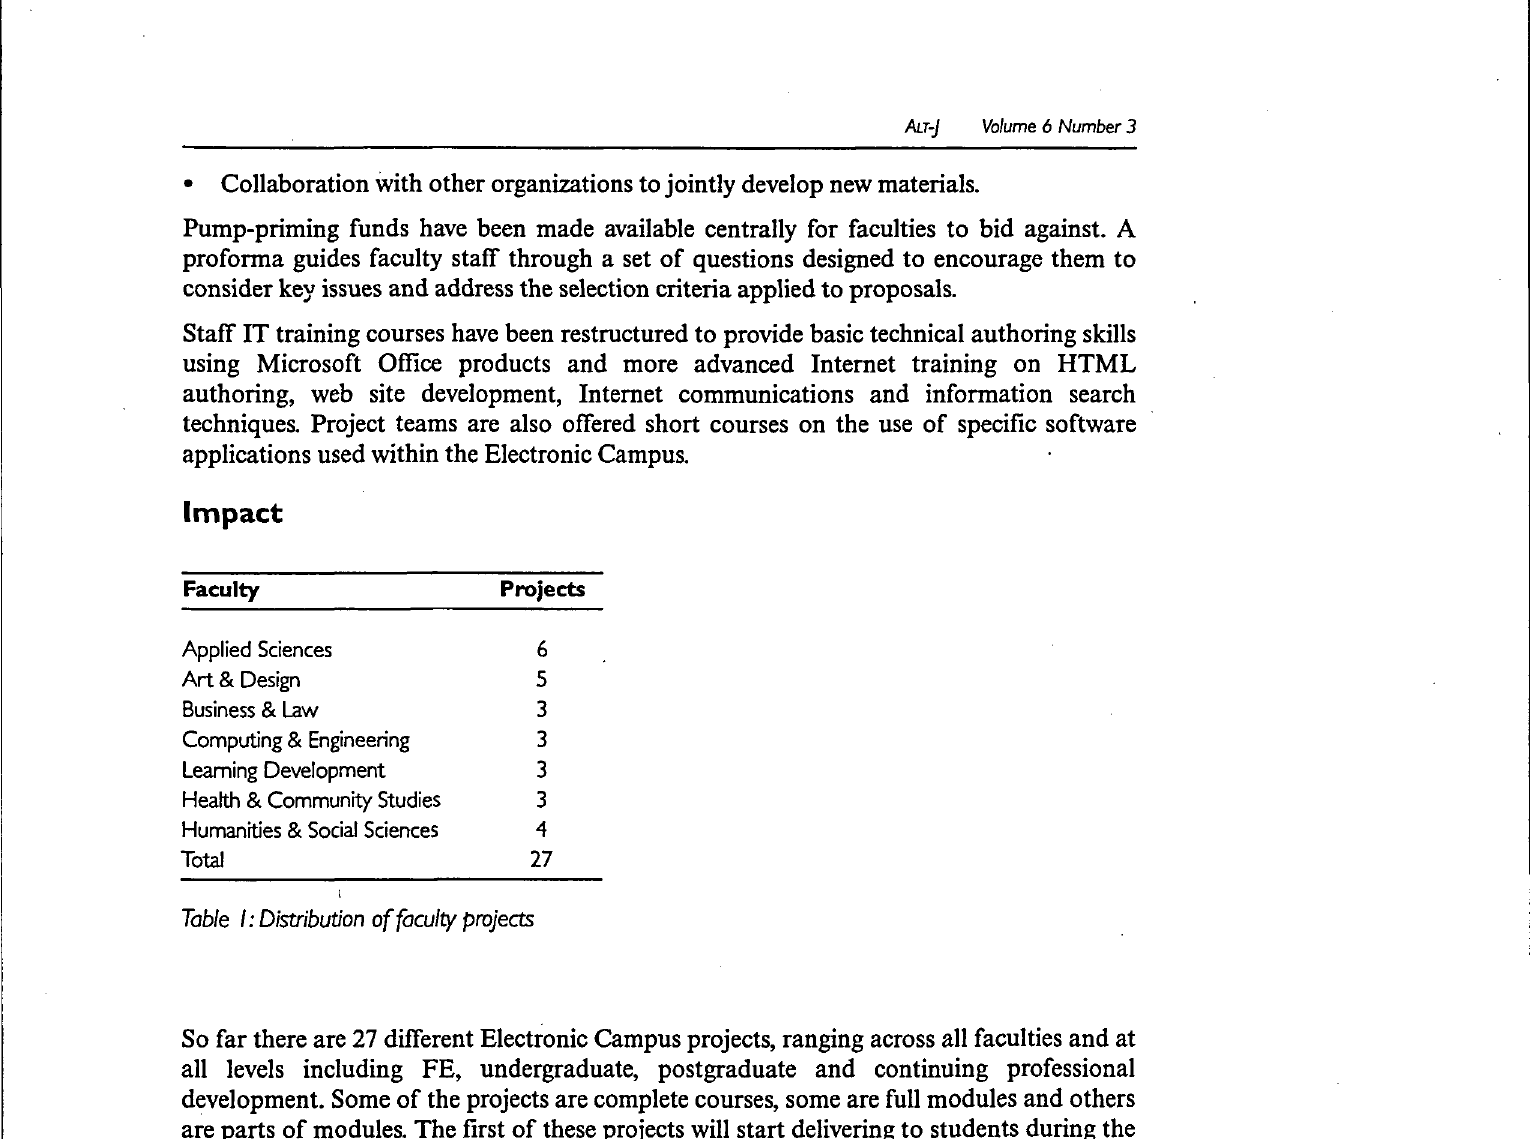
Table I : Distribution of faculty